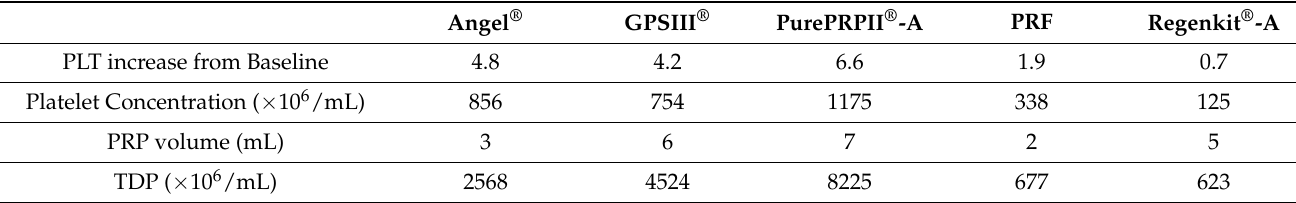
Table 1. Platelet concentration and platelet dosing discrepancies as quality indicators for injected PRP in same patient